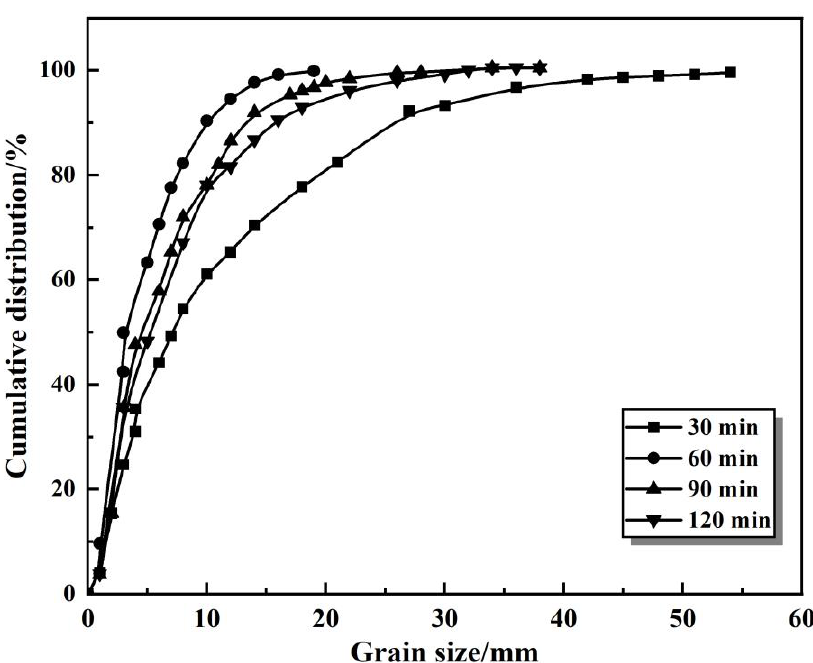
Figure 5. Relationship between grinding time and particle size of lead – zinc tailings [95].